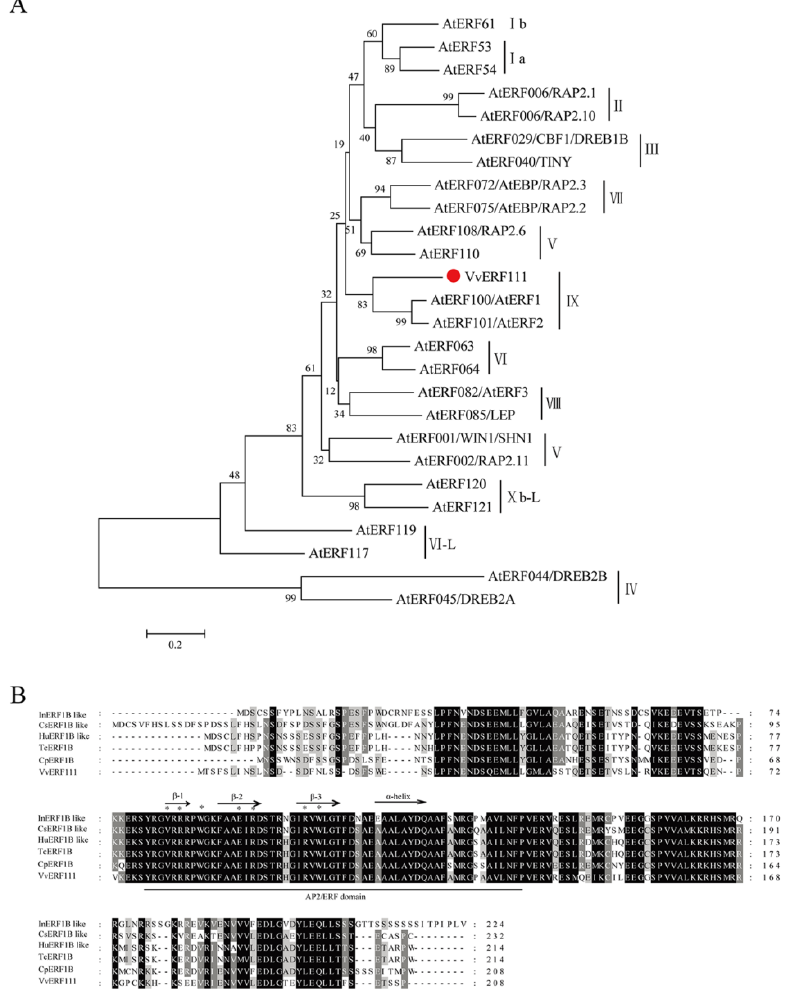
Figure 1. Sequence analysis of VvERF111. ( A ) Phylogenetic analysis of VvERF111 and the ERF proteins from Arabidopsis thaliana representing each of the 12 families. ( B ) Multiple amino acid sequence alignment of VvERF111 and homologous proteins from Ipomoea nil (XP_019181066), Camellia sinensis (XP_028082616), Herrania umbratica (XP_021290986), Theobroma cacao (EOY06019), and Carica papaya (XP_021899534). Black line underlined letters represent AP2/ERF domain. Predicted α -helix and β -sheet regions were denoted with black bar and arrows. Asterisks represent amino acid residues that directly make contact with